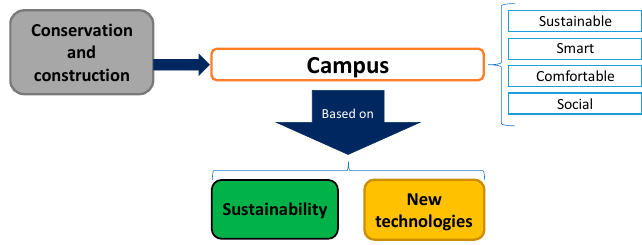
Figure 2. University of Málaga (UMA) Smart-Campus areas.